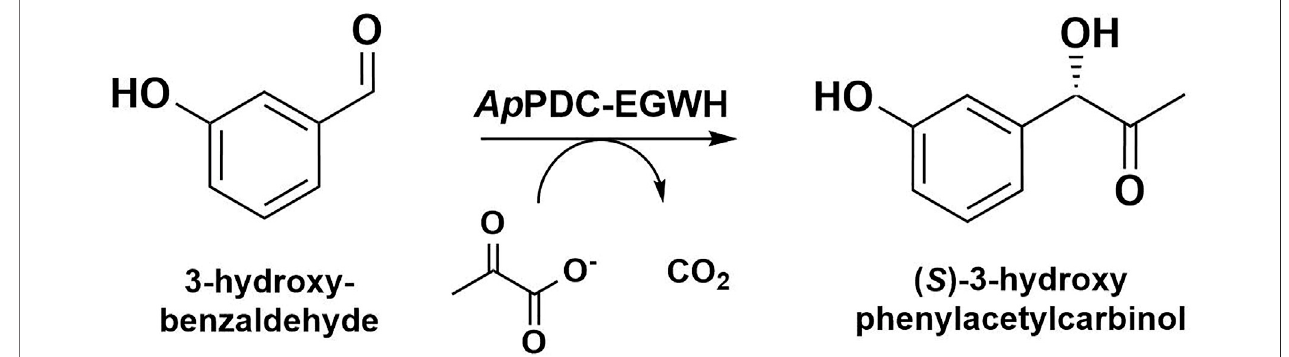
FIGURE 1 | Carboligation of 3-hydroxybenzaldehyde and pyruvate to ( S )-3-hydroxyphenylacetylcarbinol (( S )-3-OH-PAC) and CO 2 catalyzed by the pyruvate decarboxylase variant E469G/W543H from Acetobacter pasteurianus ( Ap PDC-EGWH).